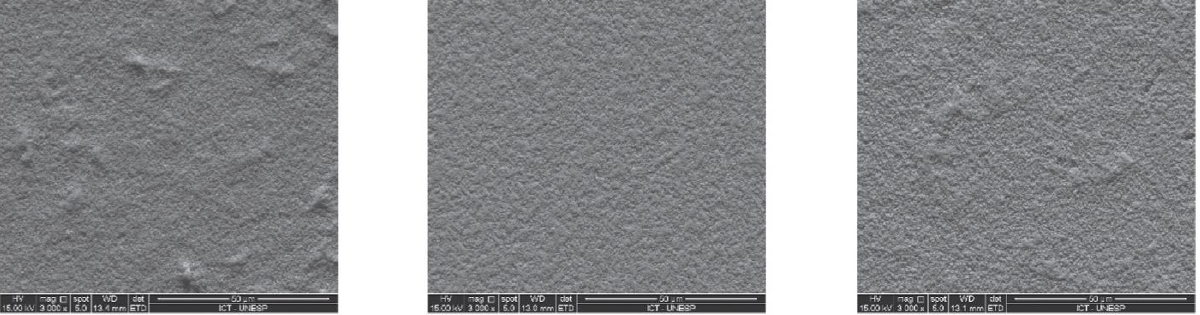
Figure 3: SEM-microphotograph of 5% etched ZrO 2 samples: a) 30 s etching, b) 60 s etching, b) 90 s etching